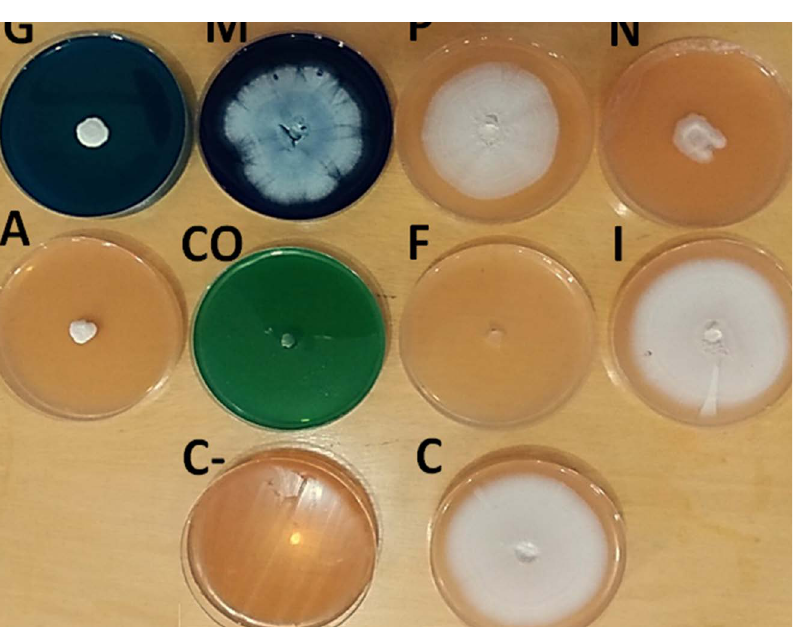
Fig. 3. Radial growth diameter test, G= Malachite green 5mg/l, M= Methylene blue 10mg /l, P= Potassium permanganate 20 ppm, N= NaCl 5% , A= Quaternary ammonium 0.5ml/l , CO= Copper sulfate 0.5mg/l, F= Formalin 250 ppm and I= Povidone iodine 100mg/l, C+=Control positive, C- = Control negative.